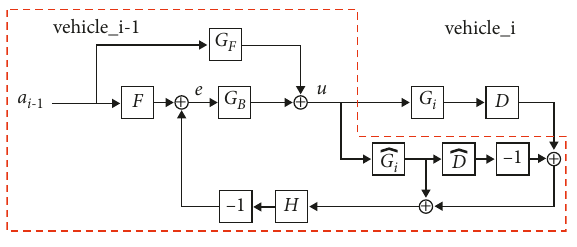
Figure 4: The control block diagram of SPC-based master-slave